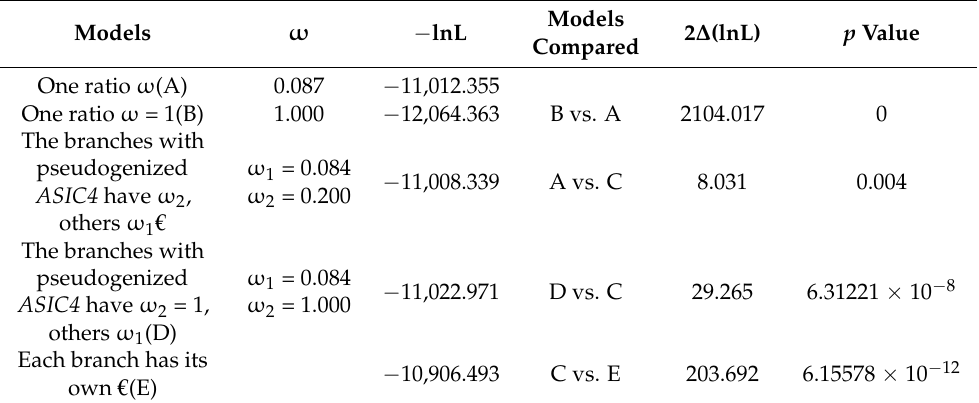
Table 1. Analysis of selective pressure relaxation in the ASIC4